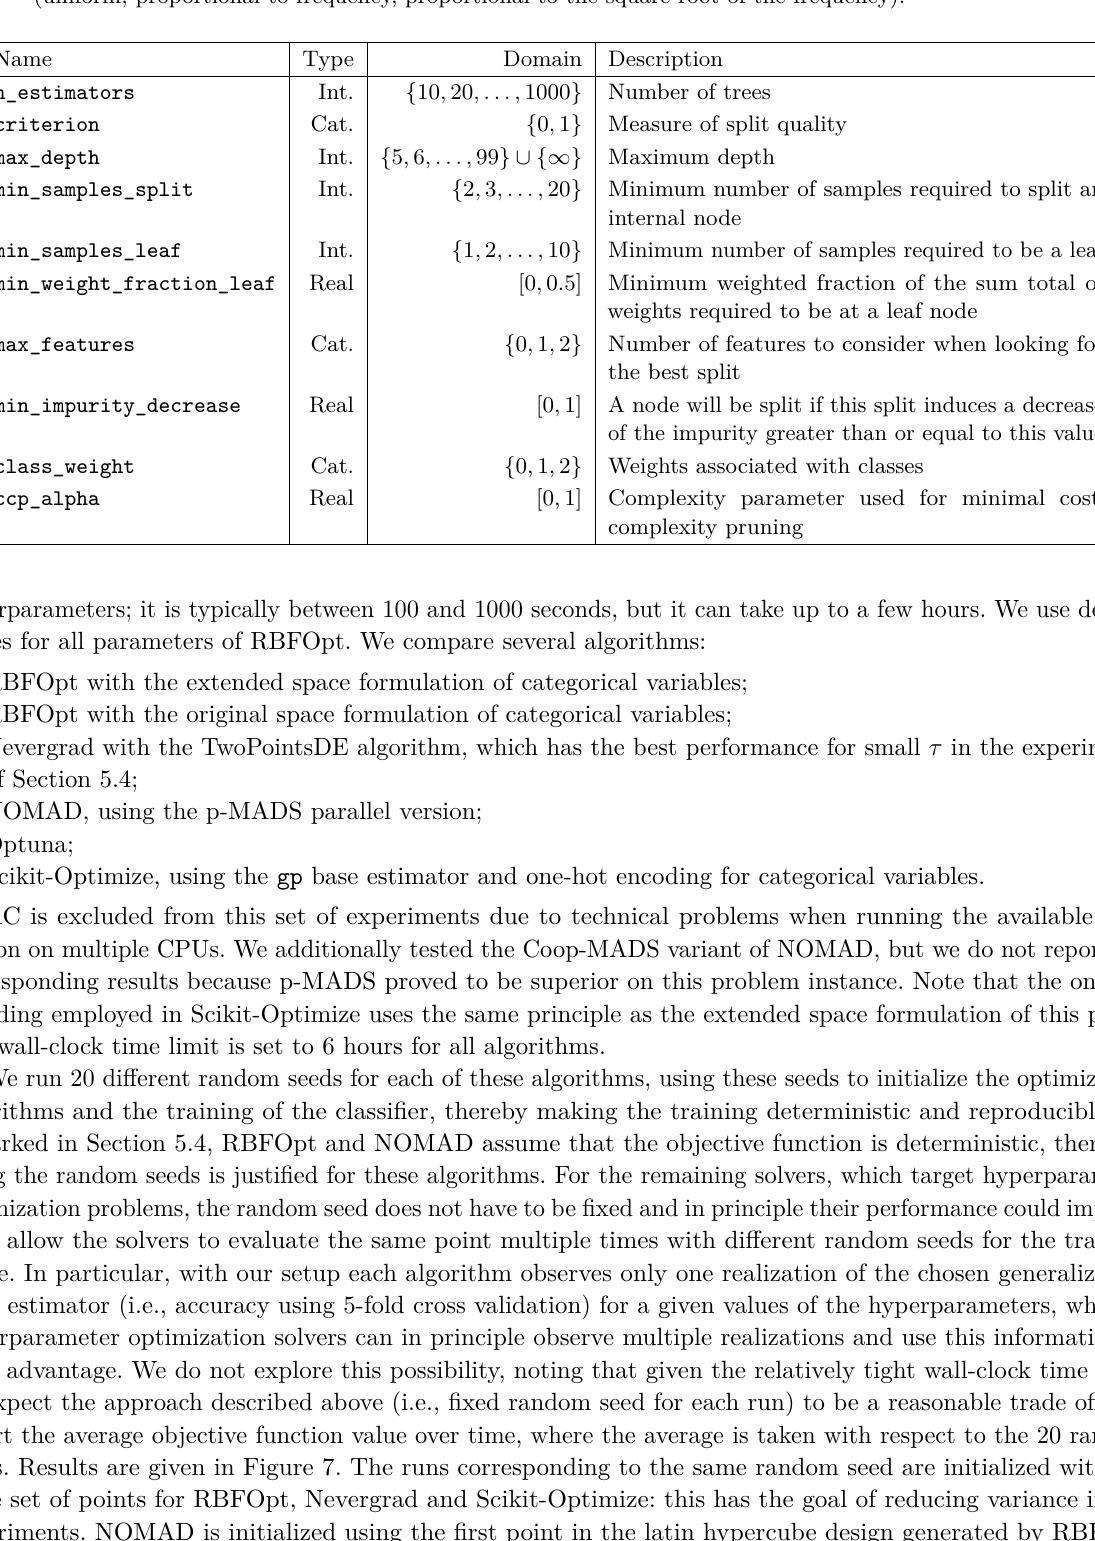
Table 5 Hyperparameters of the random forest classifier. For max_features , the choices are √ num_features , log(num_features) , num_features; for class_weight , the choices are given by three vectors of weights that attempt to rebalance the proportion of samples in each class in different ways (uniform, proportional to frequency, proportional to the square root of the